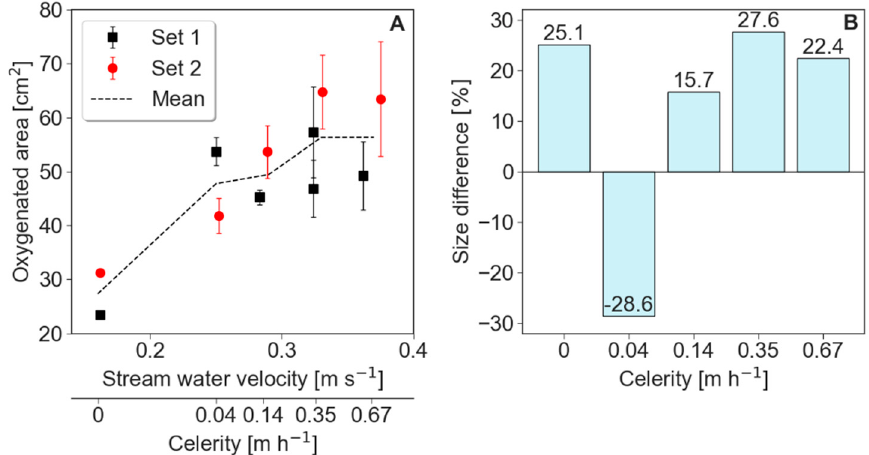
Figure 3. The spatial and temporal mean of the total oxygenated area under di ff erent stream water velocities and celerities ( A ). Each condition is displayed chronologically as Set 1 and 2, and the dotted line is the arithmetic mean. Error bars denote standard deviations of each measurement. In general, the areas in Set 2 were greater than in Set 1, except for bed form celerity of 0.14 m · h − 1 , as shown by the percentage di ff erence in area size between Set 1 and 2 ( B ).